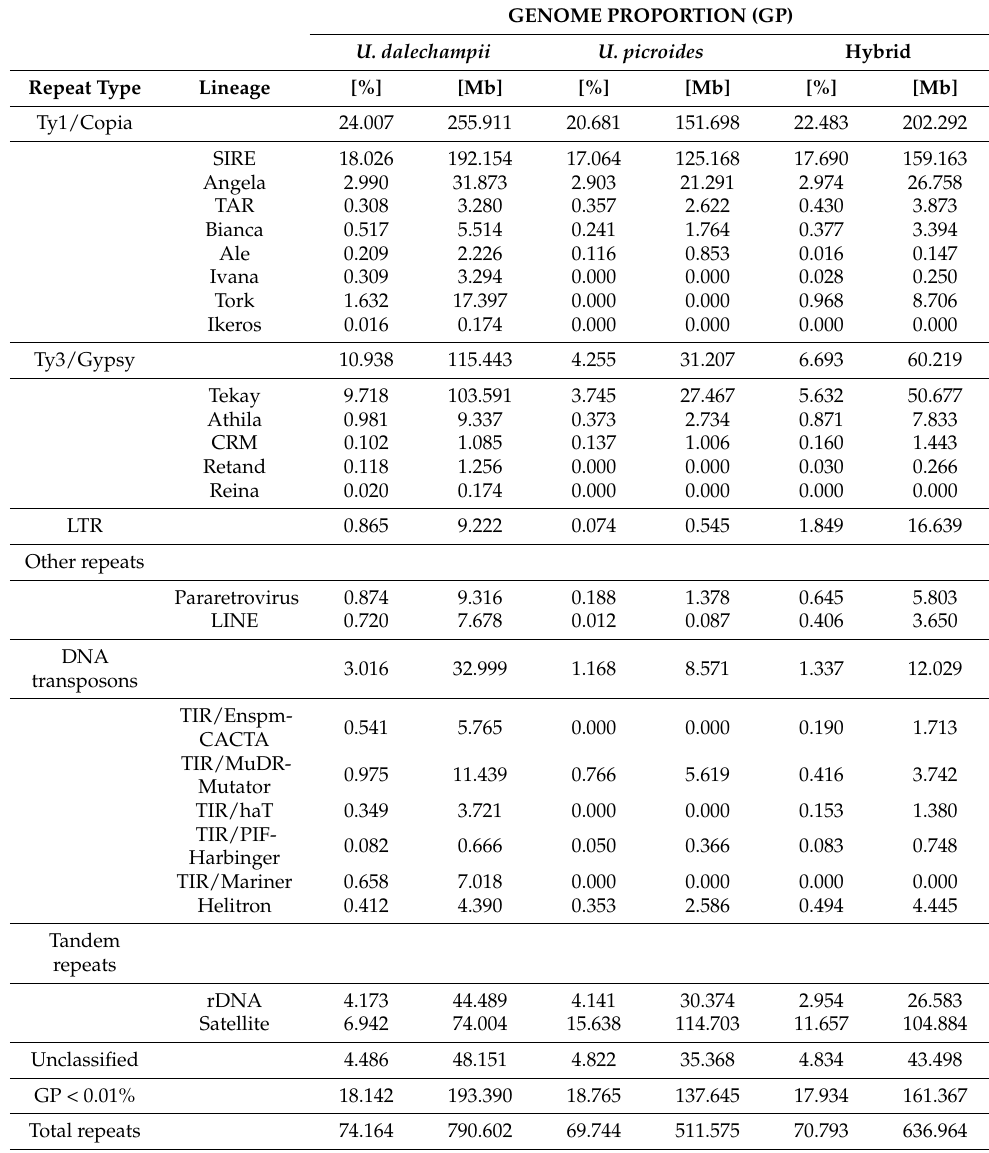
Table 4. Repeat composition inferred in the studied Urospermum species and the putative hybrid U. dalechampii × U. picroides